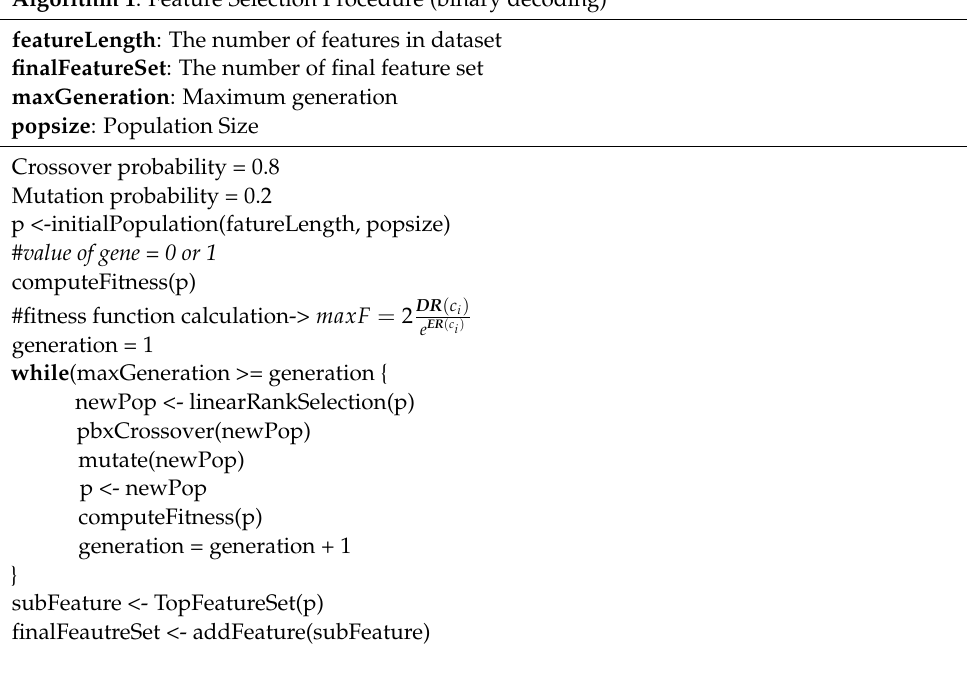
Algorithm 1 : Feature Selection Procedure (binary